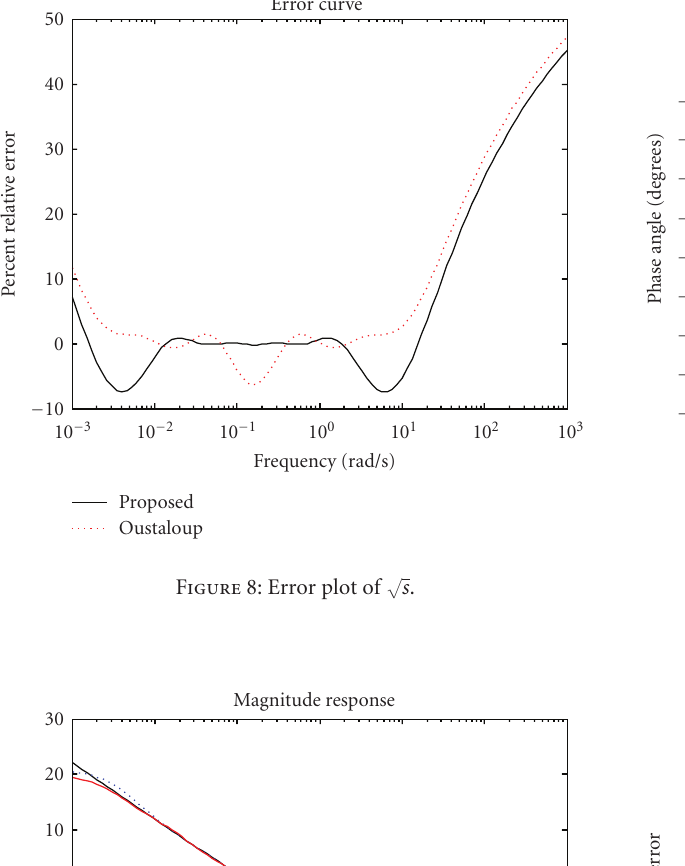
Figure 8: Error plot of